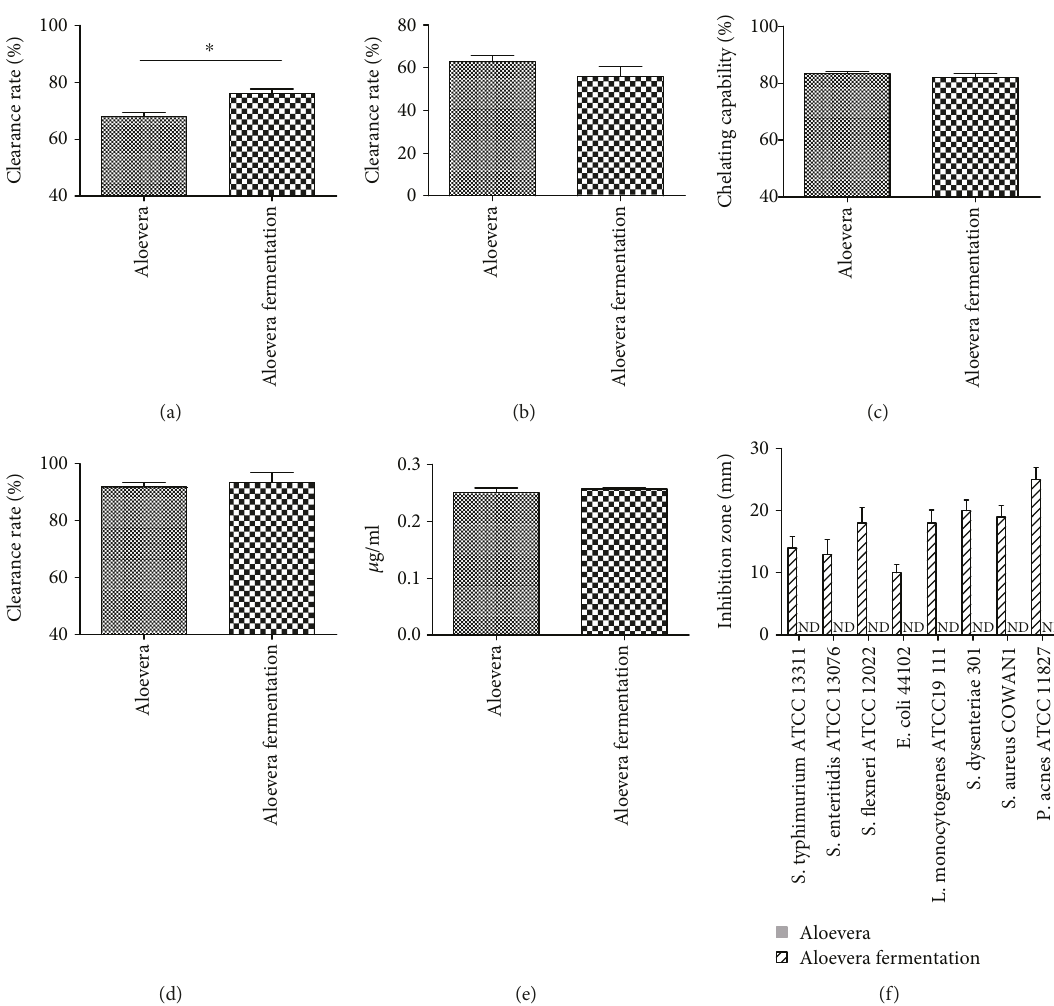
Figure 1: The antioxidant e ff ect of Aloe vera and Aloe vera + L. plantarum are shown in the clearance rate of OH - (a), clearance rate of DPPH (b), chelation rate of Fe 2+ (c), clearance rate of O 2- (d), and the total reducing power (e). The antimicrobial activity of the Aloe vera and Aloe vera + L. plantarum against the pathogens which have been selected and cultured in MRS is shown in (f). Data are shown as the mean ± SD. ∗ p < 0 05